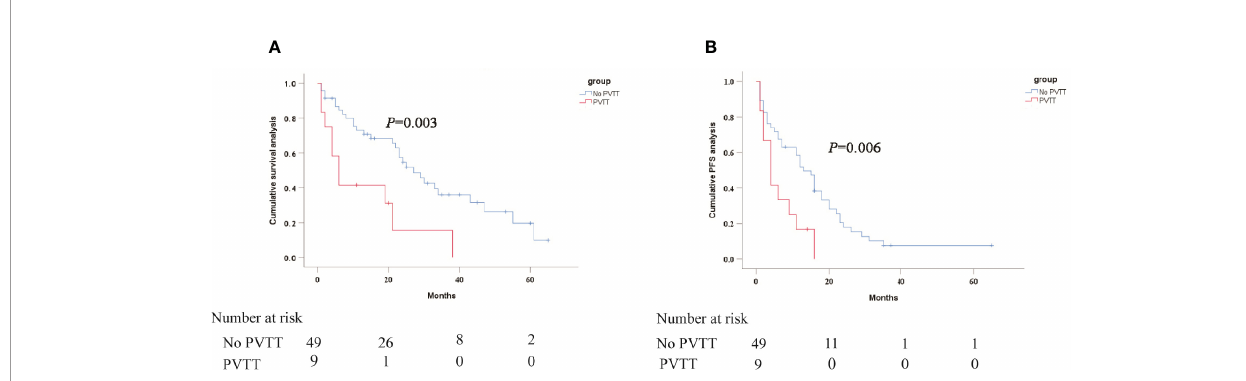
FIGURE 4 | Kaplan-Meier curves of subgroup analysis survival outcomes by MVI.